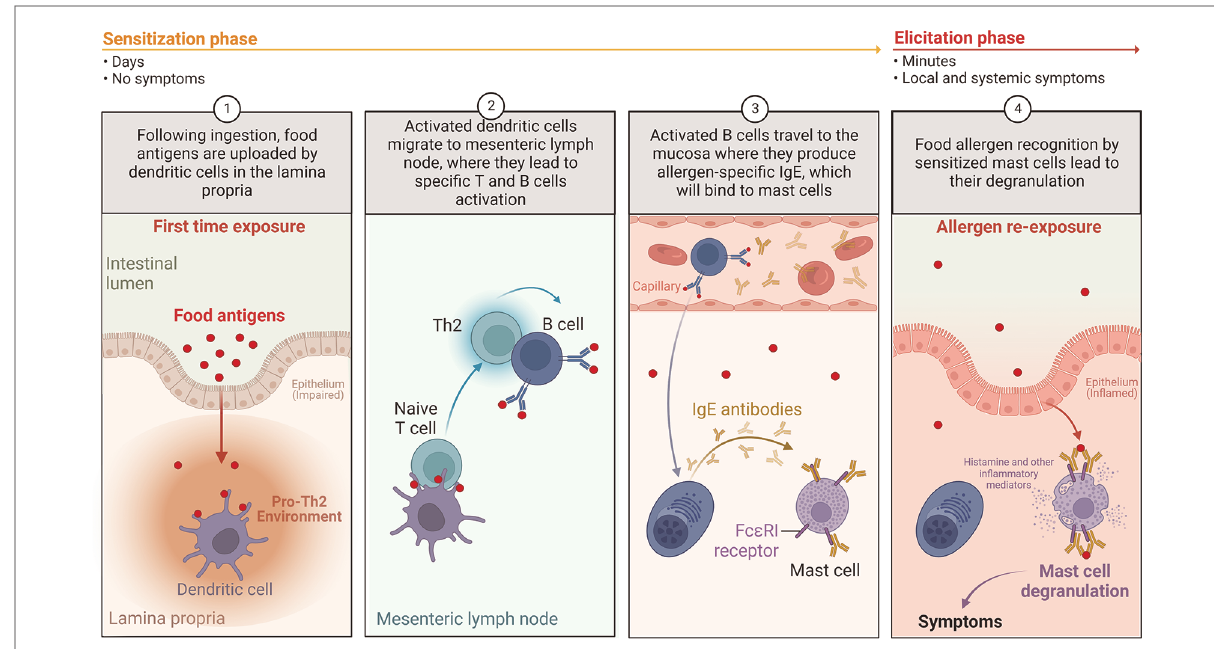
FIGURE 2 The development of IgE-mediated food allergy in humans. During the allergic “ sensitization phase ” , in the setting of an impaired barrier and a pro- Th2 environment: (1) following ingestion, food allergens are absorbed and uploaded by/delivered to dendritic cells in the lamina propria; (2) loaded dendritic cells migrate to mesenteric lymph nodes, where they prime naïve T cells in the presence of pro-Th2 cytokines. Th2 cells will activate antigen-speci fi c B cells, leading to isotype switching to IgE; (3) Activated B cells will then differentiate into plasma cells and produce signi fi cant amounts of allergen-speci fi c IgE (sIgE); (4) Secreted sIgE bind to high af fi nity Fc ϵ RI receptors on the surface of mucosal mast cells. When exposed to allergens again, allergen is recognized by sIgE bound to mast cells, leading to mast cell activation and release of preformed (histamine, tryptase, etc.) and de novo -synthesized (leukotrienes, prostaglandins, Th2 cytokines, etc.) pro-in fl ammatory mediators. This corresponds to the “ elicitation phase ” of the acute reaction, leading to Th2 local in fl ammation and clinical symptoms (Created with